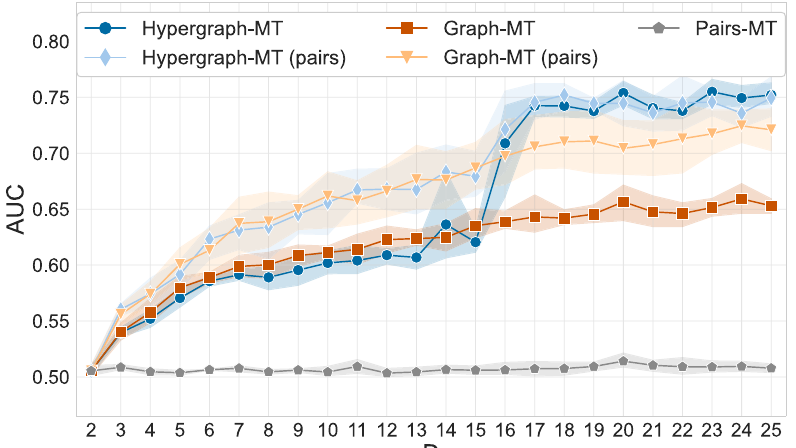
balanced comparison against Pairs-MT, for Hypergraph-MT and Graph-MT we additionally measure the AUC on the subset of test hyperedges of size 2 (pairs), while still training on the whole train set. The plot shows the existence of a critical hyperedgesizebeyondwhichthehigher-orderalgorithmsigni fi cantlyoutperforms alternative methods.